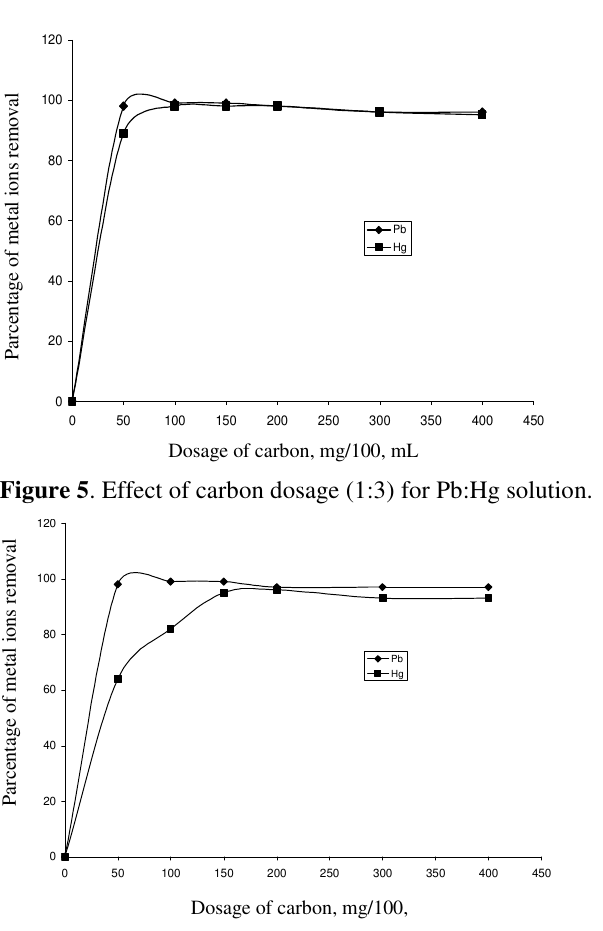
Figure 6 . Effect of carbon dosage (1:4) for Pb:Hg